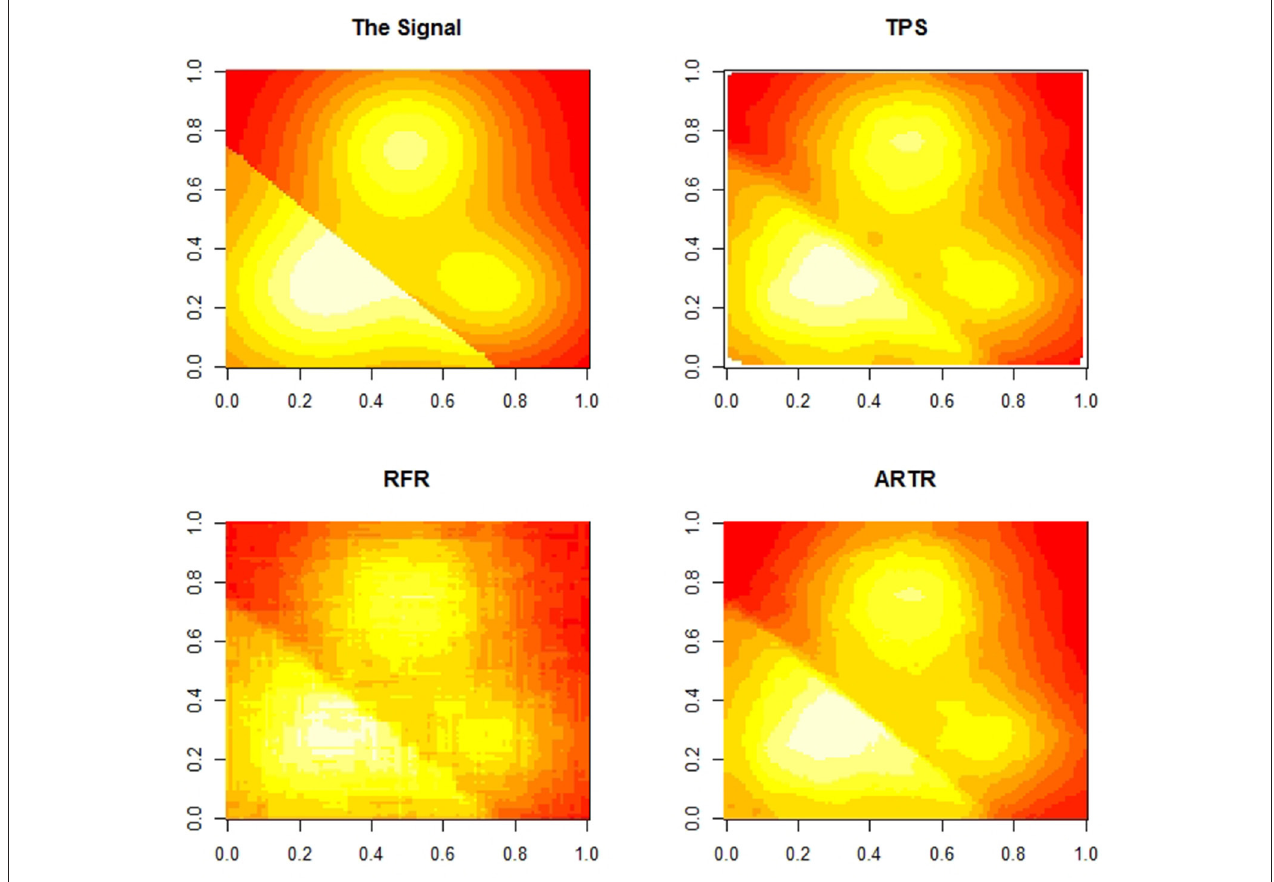
FIGURE 2 | The regression function and its estimates from different